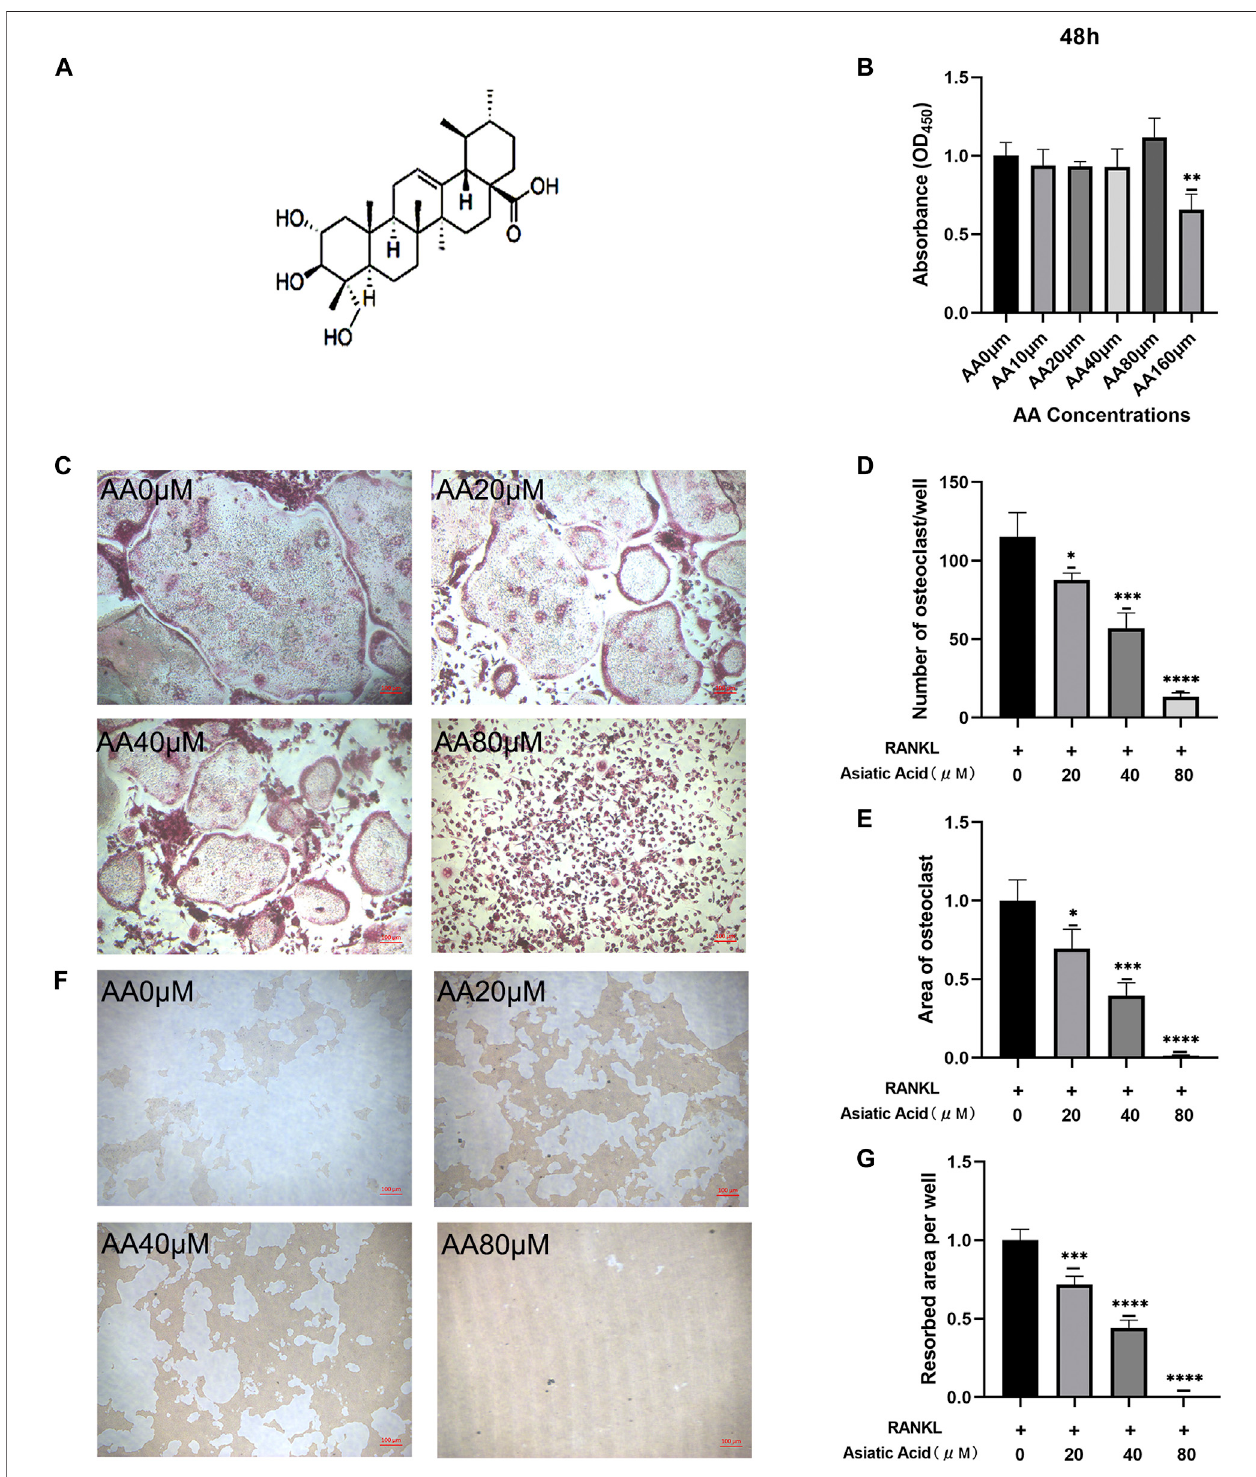
FIGURE1| Asiaticacidsuppressesthedifferentiationand boneresorption ofosteoclasts. (A) Thestructuralformula forasiaticacid. (B) Drugtoxicityofasiatic acid onBMMs.AfterBMMsweretreatedwithasiaticacidfor48 h,andtheabsorbancevalueofeachwellwasmeasuredwithaCCK8kit( n =4). (C) Representativeimagesof asiatic acid inhibition of osteoclast differentiation. BMMs were cultured in a -MEM containing 30 ng/mL M-CSF and 50 ng/ml RANKL with or without asiatic acid. After 7 days,thecellswere fi xedin4%paraformaldehydeandstainedwithTRAP( n =3). (D,E) Quantitativeanalysisofthenumberand areaproportionofTRAP-positive osteoclasts ( ≥ 3 nuclei) ( n = 3). (F) Representative images of asiatic acid inhibition of bone resorption. (G) Quanti fi cation analyses of the resorbed area per well ( n = 3). All values are presented as the mean ± SD ( n = 3). * p < .05; ** p < .01; *** p < .001; **** p < .0001.